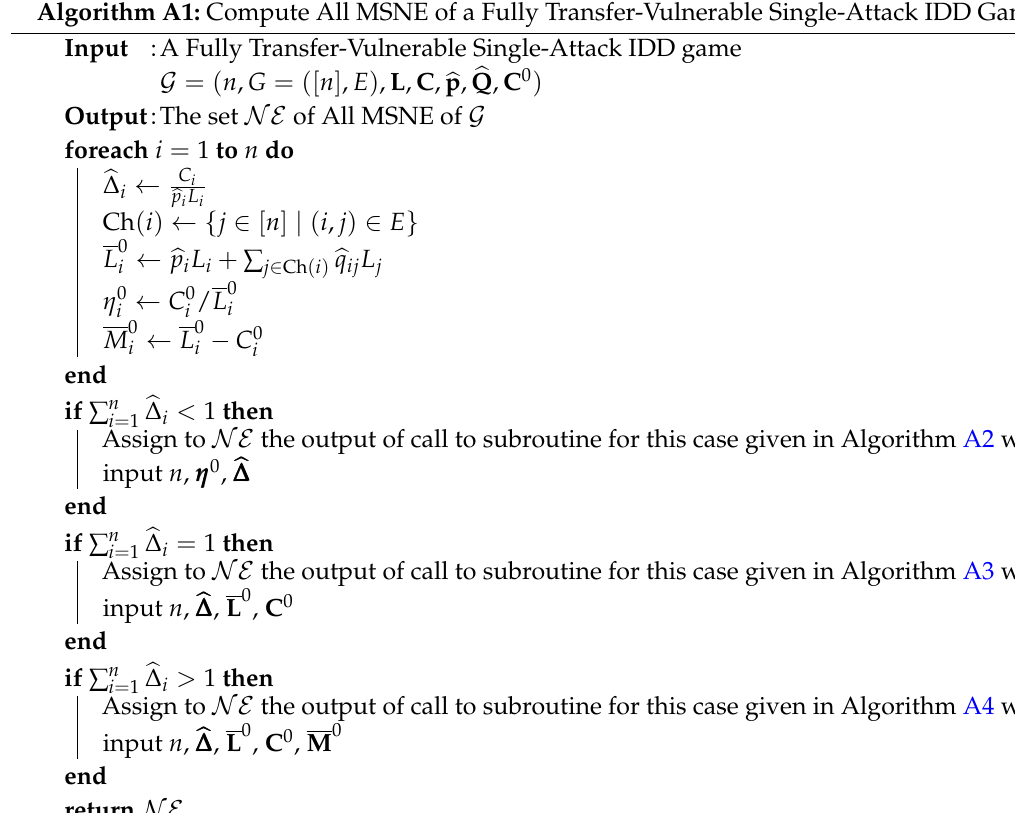
Algorithm A1: Compute All MSNE of a Fully Transfer-Vulnerable Single-Attack IDD